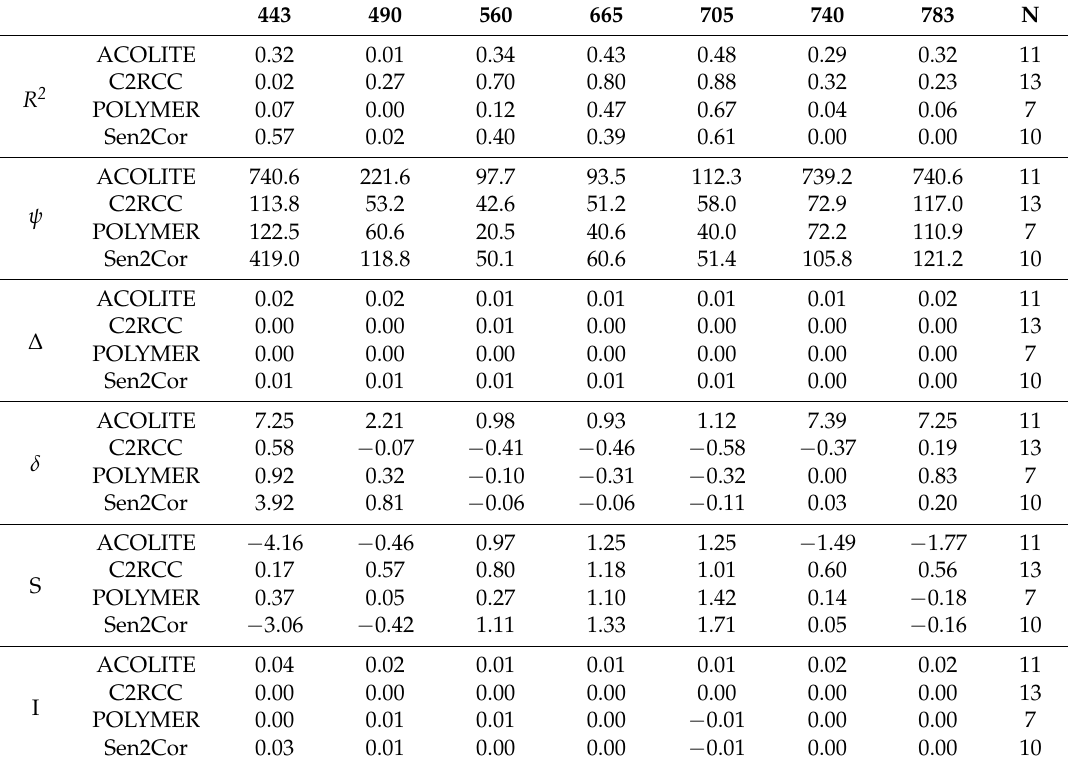
Table 4. Comparison of atmospheric correction (AC) processors (ACOLITE, C2RCC, Sen2Cor, POLYMER) at S2 MSI bands based on the calculated statistics: coefficient of determination ( R 2